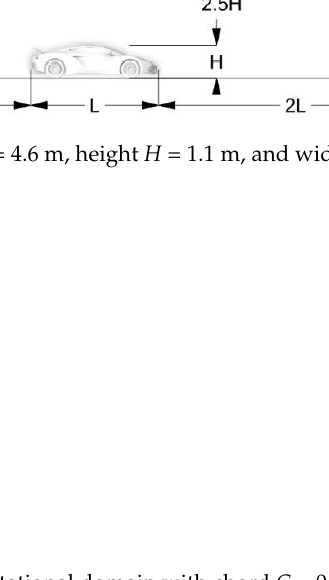
Figure 8. Size of the front wing computational domain with chord C = 0.3 m and span S = 0.7